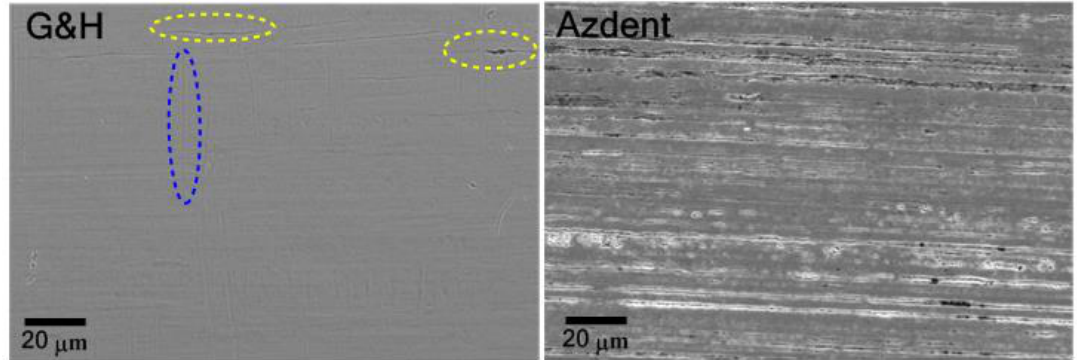
Figure 5. SEM micrographs of G&H ( left ) and Azdent ( right ) stainless steel archwires at 2000 × magnification, scale bar 20 µ m. Horizontal and vertical striations (along and perpendicular to the wire axis, respectively), as well as surface pitting are present in both samples, yet much less apparent or regular in G&H; dashed ovals assist in highlighting these features.